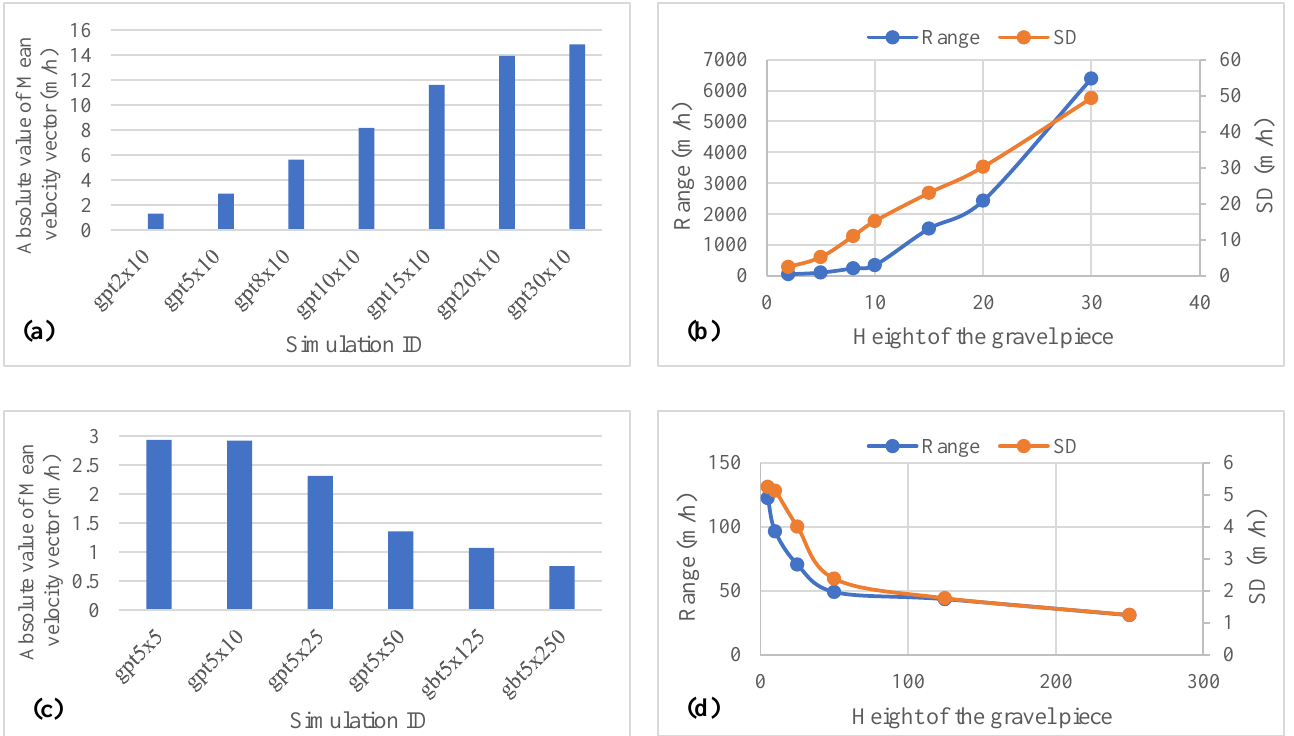
Figure 13. Effect of change in the height ( a , b ) and base width ( c , d ) of gravel piece on the velocity vector field. Mean, range, and SD are shown to compare the impact of varying gravel size.